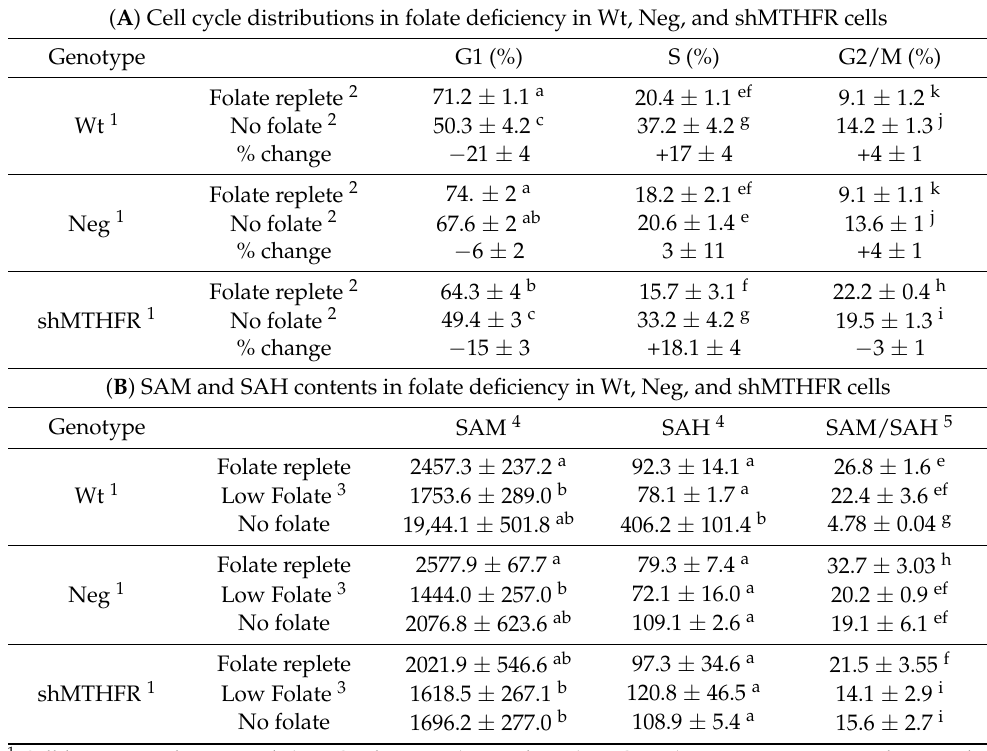
Table 3. Effects of MTHFR knockdown and folate depletion on cell cycle distribution and SAM, SAH contents in HepG2